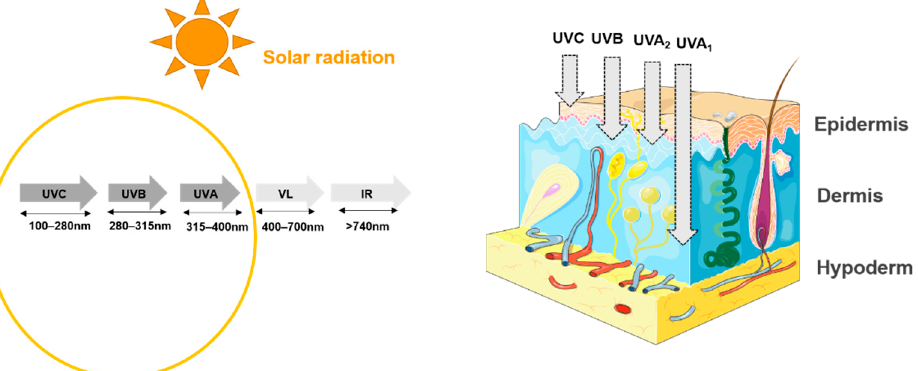
Figure 2 . Spectrum of solar radiation. VL: visible light; IR: infrared-ultraviolet radiation accounts for 58% of the total solar spectrum and is divided into three groups, from the shortest to longest wavelength: UVC (100–280 nm), UVB (280–315 nm), and UVA (315–400 nm). Each group penetrates the skin to different depths